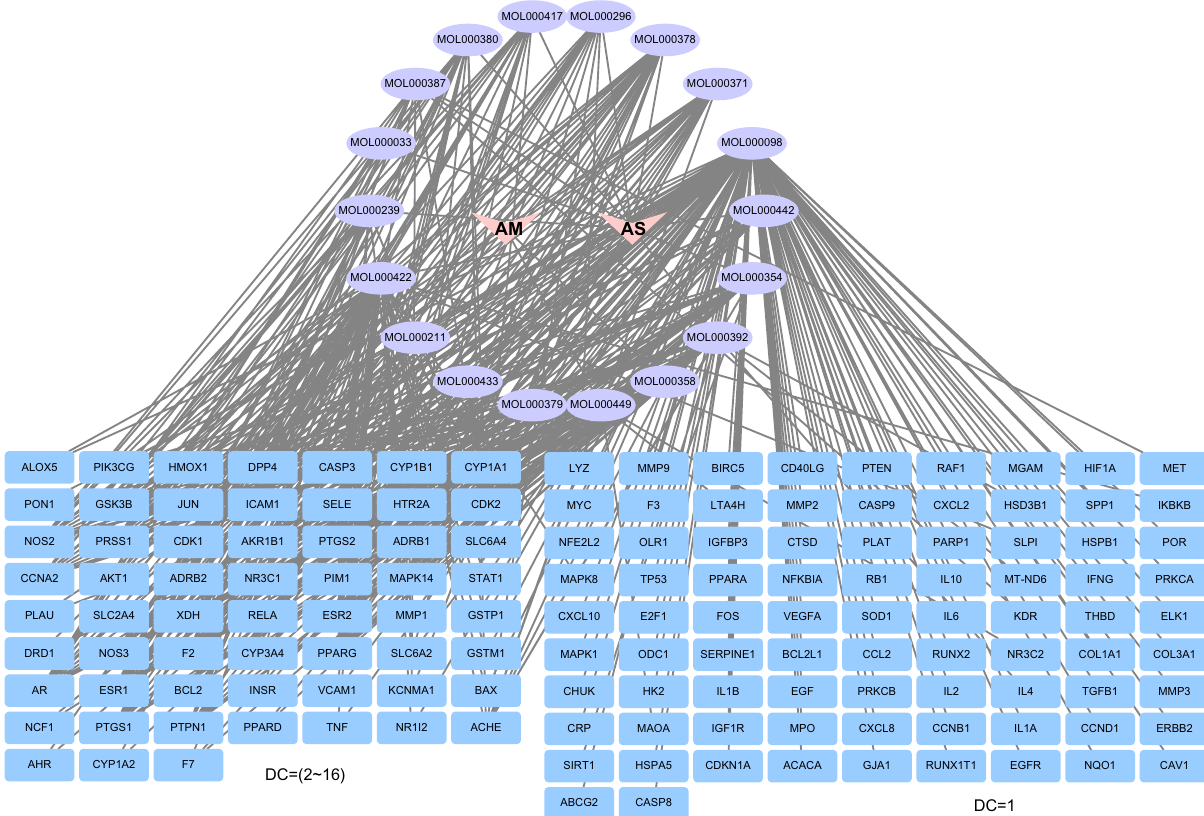
Figure 4. Interaction network of AM&AS compound- DN-targets. The red triangles represent AM and AS, the purple circles represent the active components, and the blue rectangles represent the target genes of the AM-AS compound acting on DN, which are divided by degree centrality (DC) values. The number of edges connected to the node in the network represents the degree of